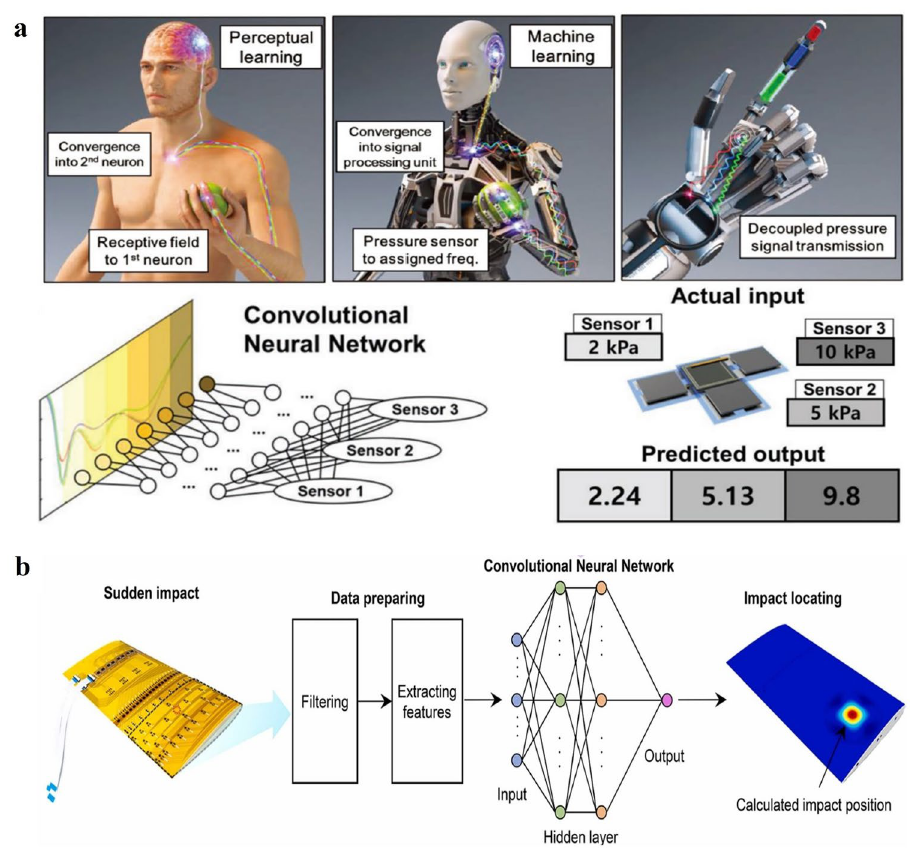
Fig. 13 a Pressure prediction and position recognition of a pressure-sensing platform, which is inspired by the human somatosensory system and realized by flexible LC pressure sensor arrays and ML-based cognition [183]. Copyright (2019) Wiley–VCH. b Impact positioning of the flexible sensing skin for the flying perception of aircraft, realized by a piezoelectric sensor array and ML techniques [99]. Copyright (2021) Else-